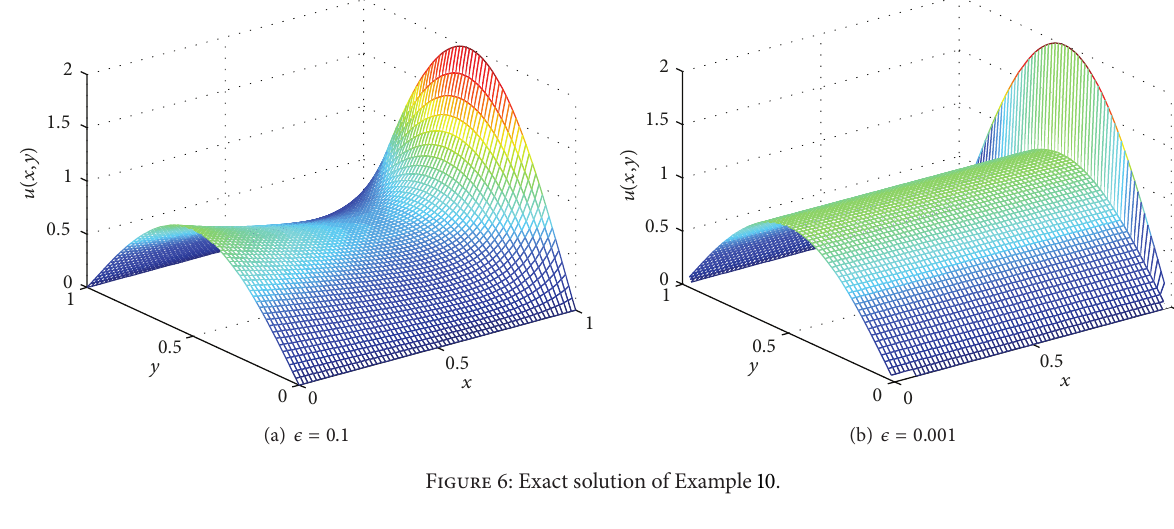
Figure 6: Exact solution of Example 10.